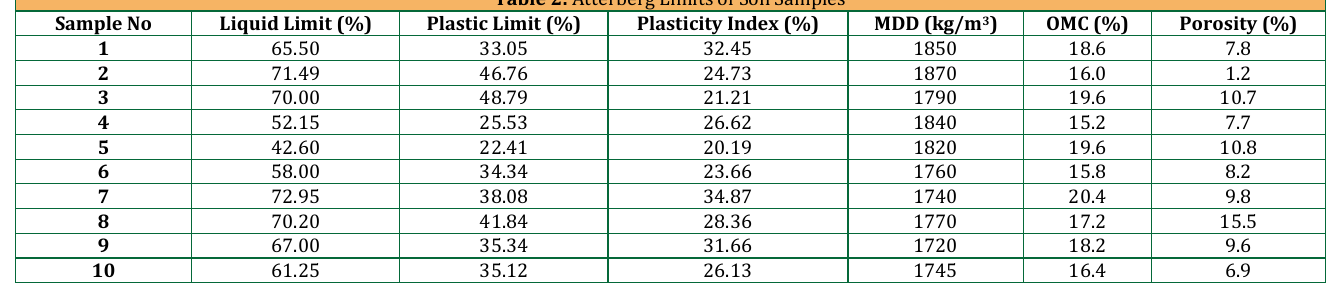
Table 2: Atterberg Limits of Soil Samples